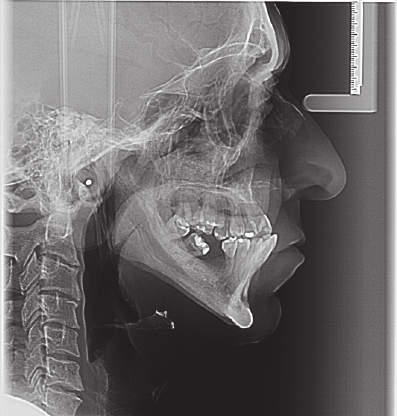
Figure 4: CBCT axial slice demonstrating rupture of the mandibu- lar cortex.